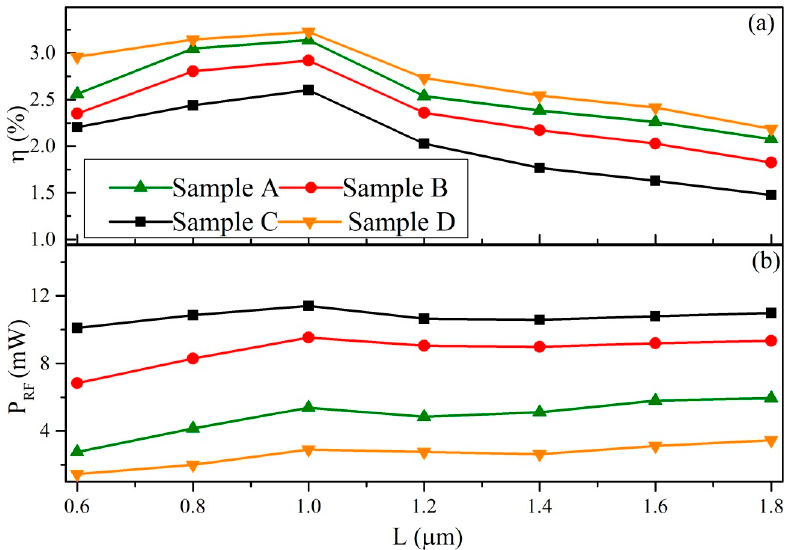
Figure 2. ( a ) The RF-to-DC efficiency η versus the channel length L; ( b ) the RF output power P RF versus L. Appl. Sci. 2020 , 10 , x FOR PEER REVIEW